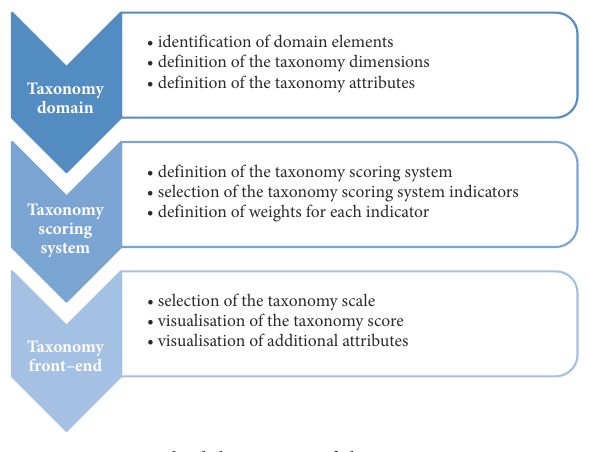
Figure 4. Methodologic steps of the taxonomy process